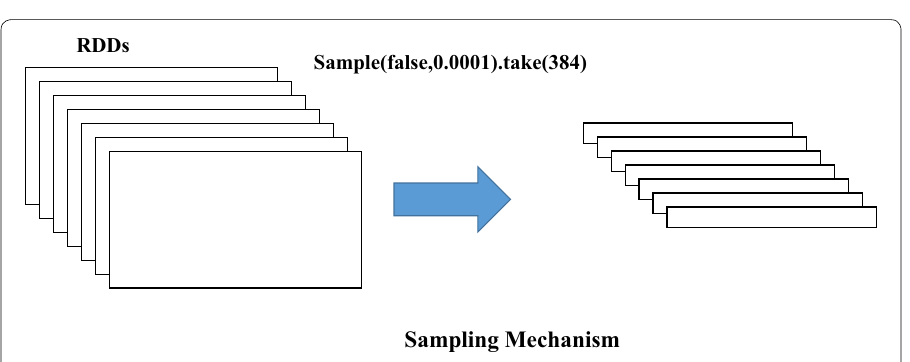
Fig. 7 Implementation of our approach in